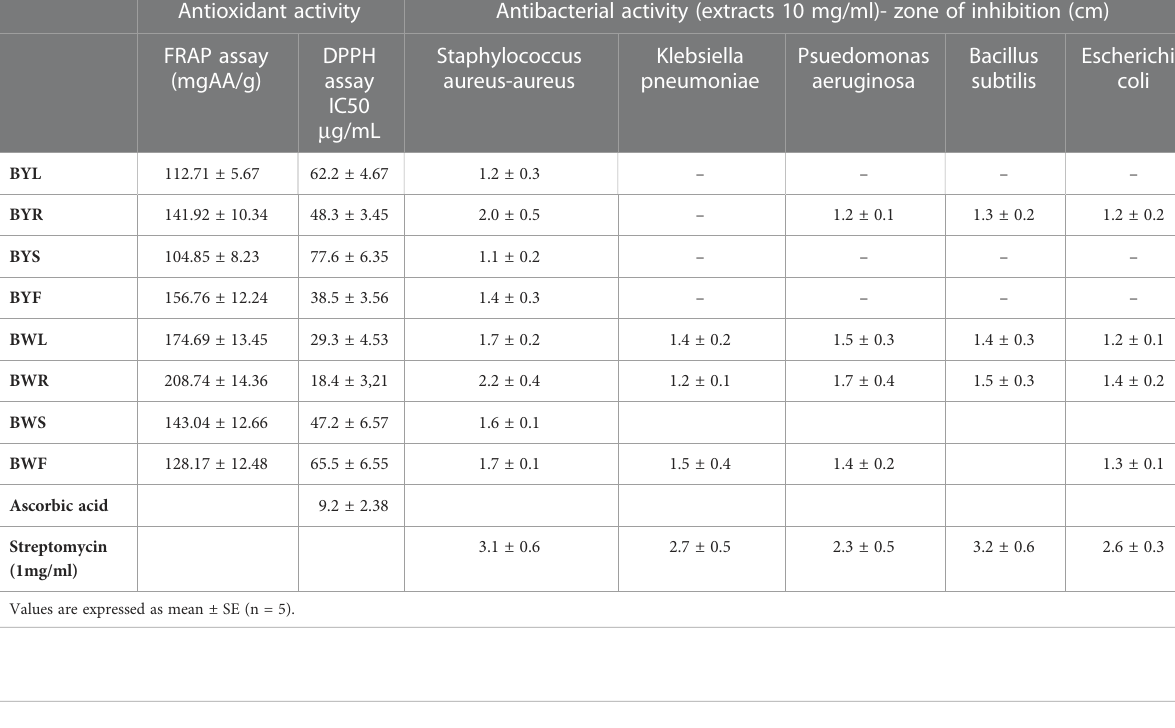
TABLE 2 Antioxidant and antibacterial activity of extracts obtained from different parts of B.prionitis and B.cristata.